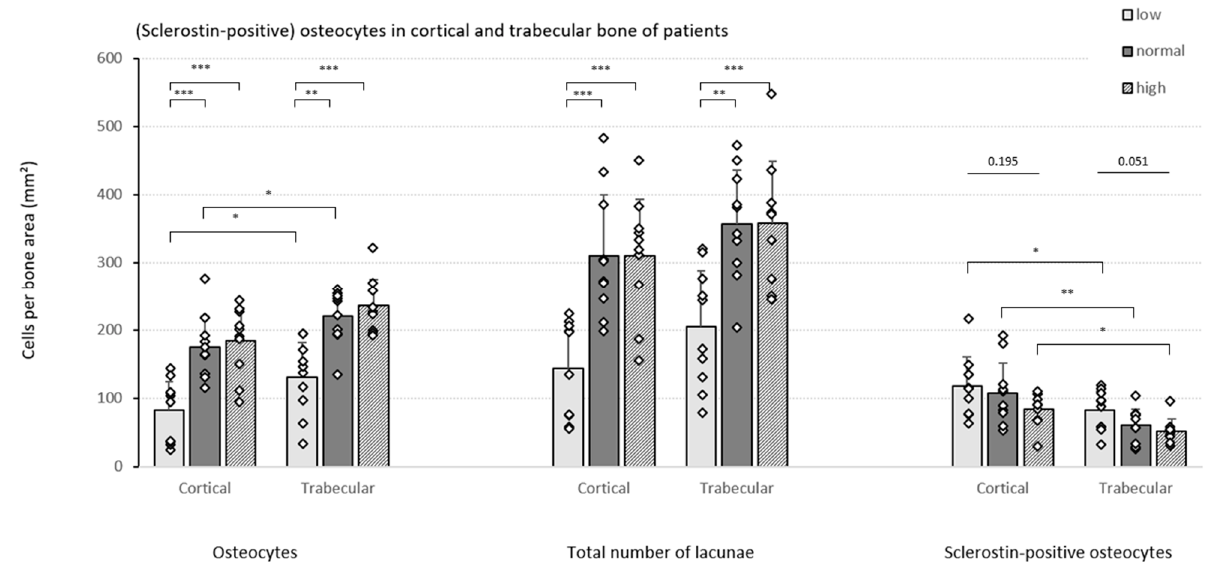
Figure 3. Cell counts in the patient cohort. Different cell counts (i.e., osteocytes, total number of lacunae and sclerostin-positive osteocytes) were determined in the cortical and trabecular bone of CKD5/transplant patients with different degrees of bone turnover ( n = 10/group). Data shown as mean ± SD. * p ≤ 0.05, ** p ≤ 0.01, *** p ≤ 0.001.